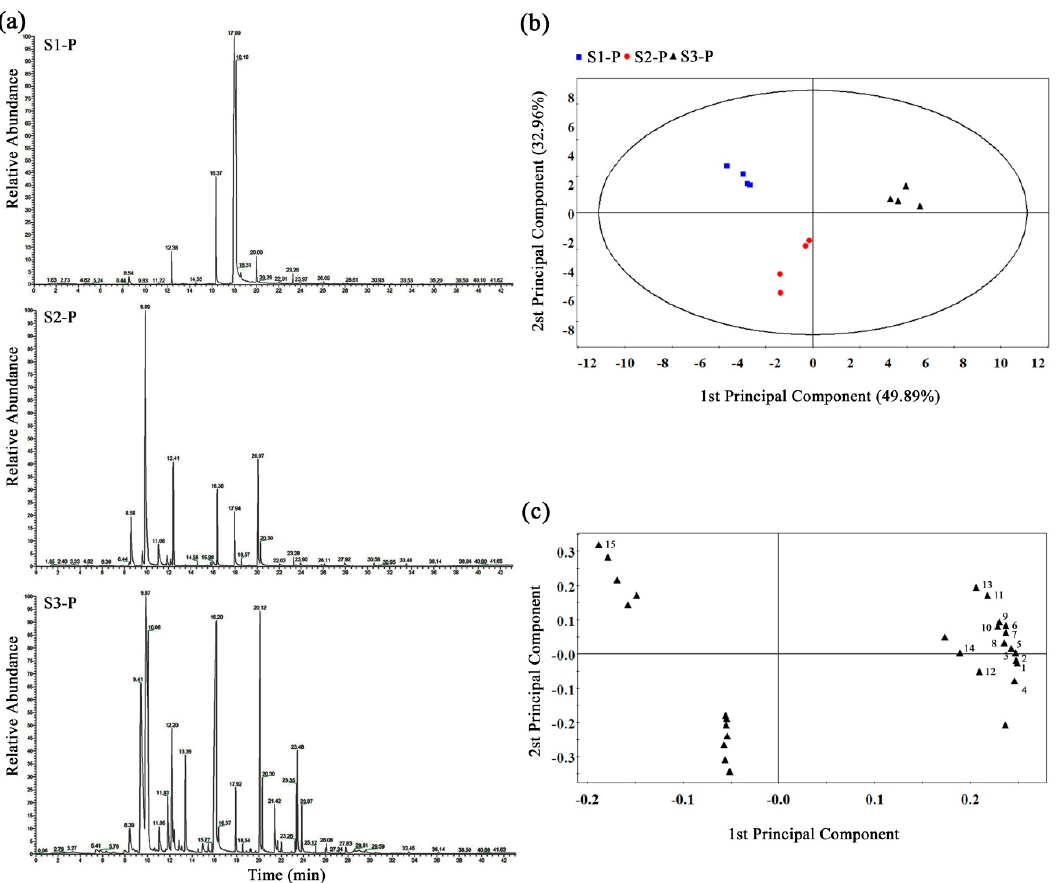
Figure 4. GC-MS metabolomic analysis of L. longituba tepals. ( a ) Typical chromatograms of L. longituba tepals under S1, S2, and S3. ( b ) Score plot and ( c ) loading plot of tepal GC-MS profiles of L. longituba according to different developmental stages using orthogonal partial least-squares discriminate analysis (OPLS-DA). Top 15 metabolites coded in the loading plot are: (1) caryophyllene, (2) trans - β -ocimene, (3) benzoic acid, methyl ester, (4) hexadecane, (5) benzoic acid, 2-phenylethyl ester, (6) β -myrcene, (7) butyl aldoxime, 3-methyl-, (8) 3-methoxy-5-methylphenol, (9) 1-butanol, 3-methyl-, benzoate,